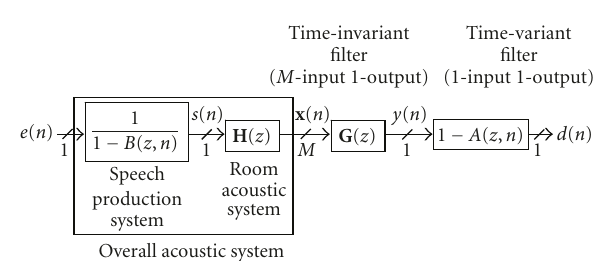
Figure 1: Schematic diagram of system producing observed signal from innovations process.